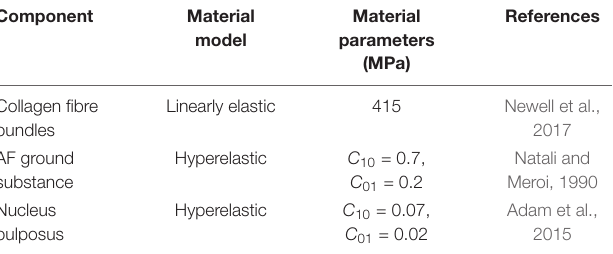
TABLE 1 | Baseline material properties for components of each of the FE models.